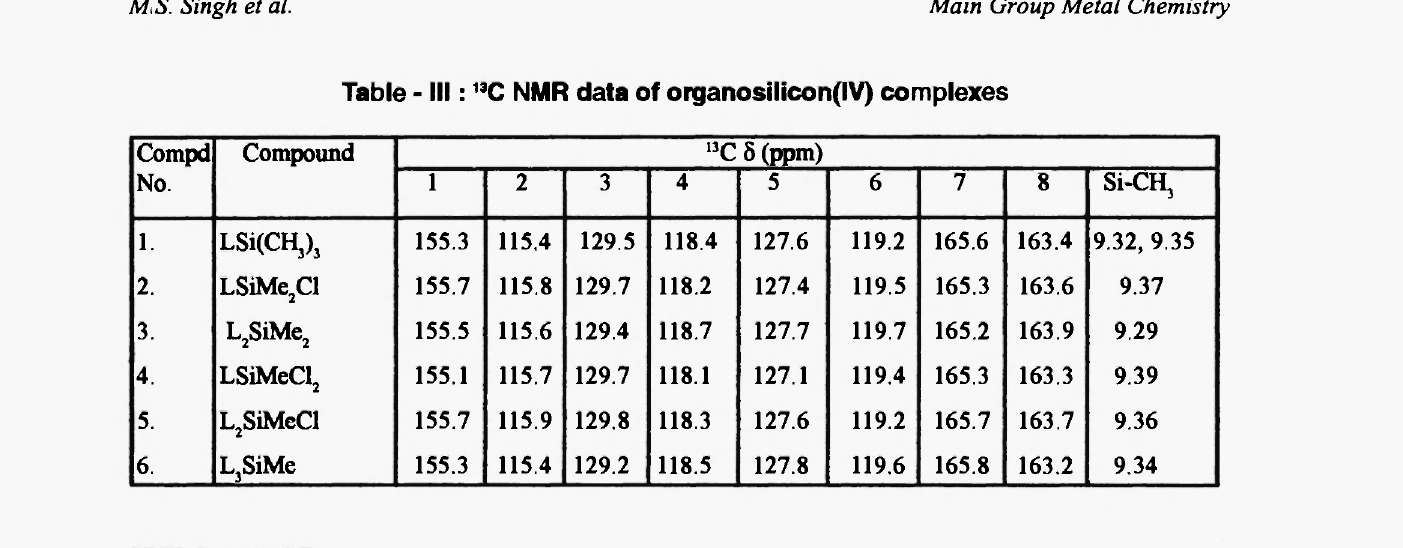
Table - III: 13 C NMR data of organosilicon(IV)